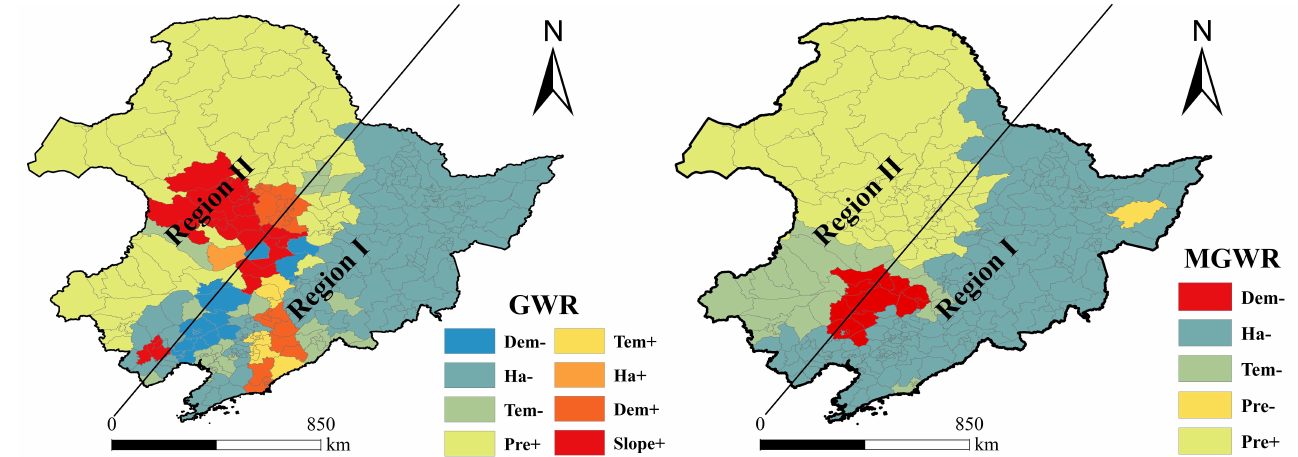
Figure 12. Spatial heterogeneity analysis of influencing factors in vegetation. A positive influence on vegetation growth (+); a negative influence on vegetation growth ( − ) and the influencing factors including precipitation (Pre), temperature (Tem), elevation (Dem), gradient (Slope) and human activity